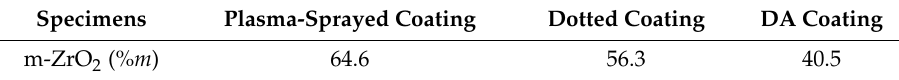
Figure 17. The XRD patterns of ( a ) the plasma-sprayed, ( b ) dotted, and ( c ) DA coatings after the hot corrosion test at the 2 θ range of 27°–33°. Table 5. Volume fractions of m-ZrO 2 (% m ) after the hot corrosion test.